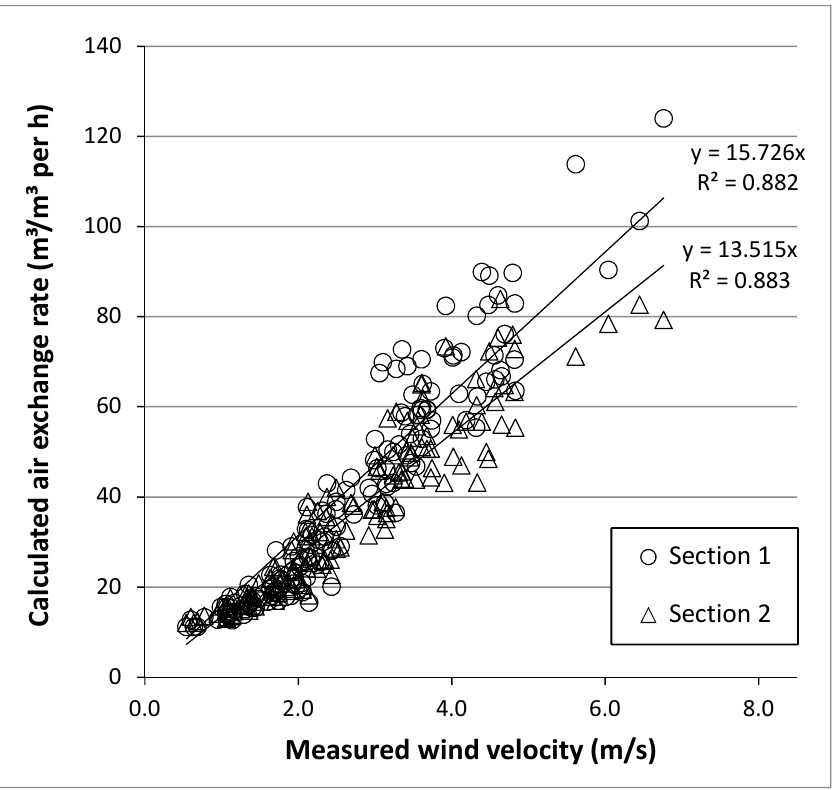
Figure 4. Relationship between the wind velocity (m/s) and the air exchange rate (m 3 /m 3 per h) in the control group (CON) (Section 1: SE = 0.232) and experimental group (EXP) (Section 2: SE = 0.176) in the winter ( n = 149) calculated with the CO 2 balance method. The point of intersection was set through zero, and the wind velocity on the x-axis starts at 0.7 m/s.